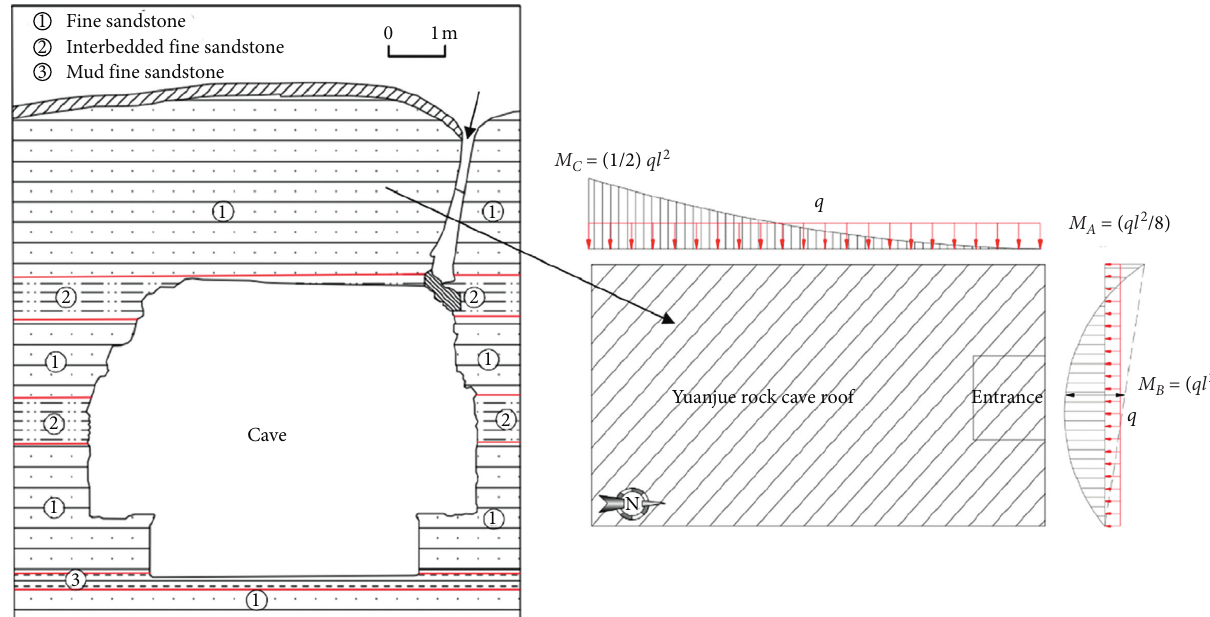
Figure 13: Sectional view of tunnel and simplified diagram of roof bending